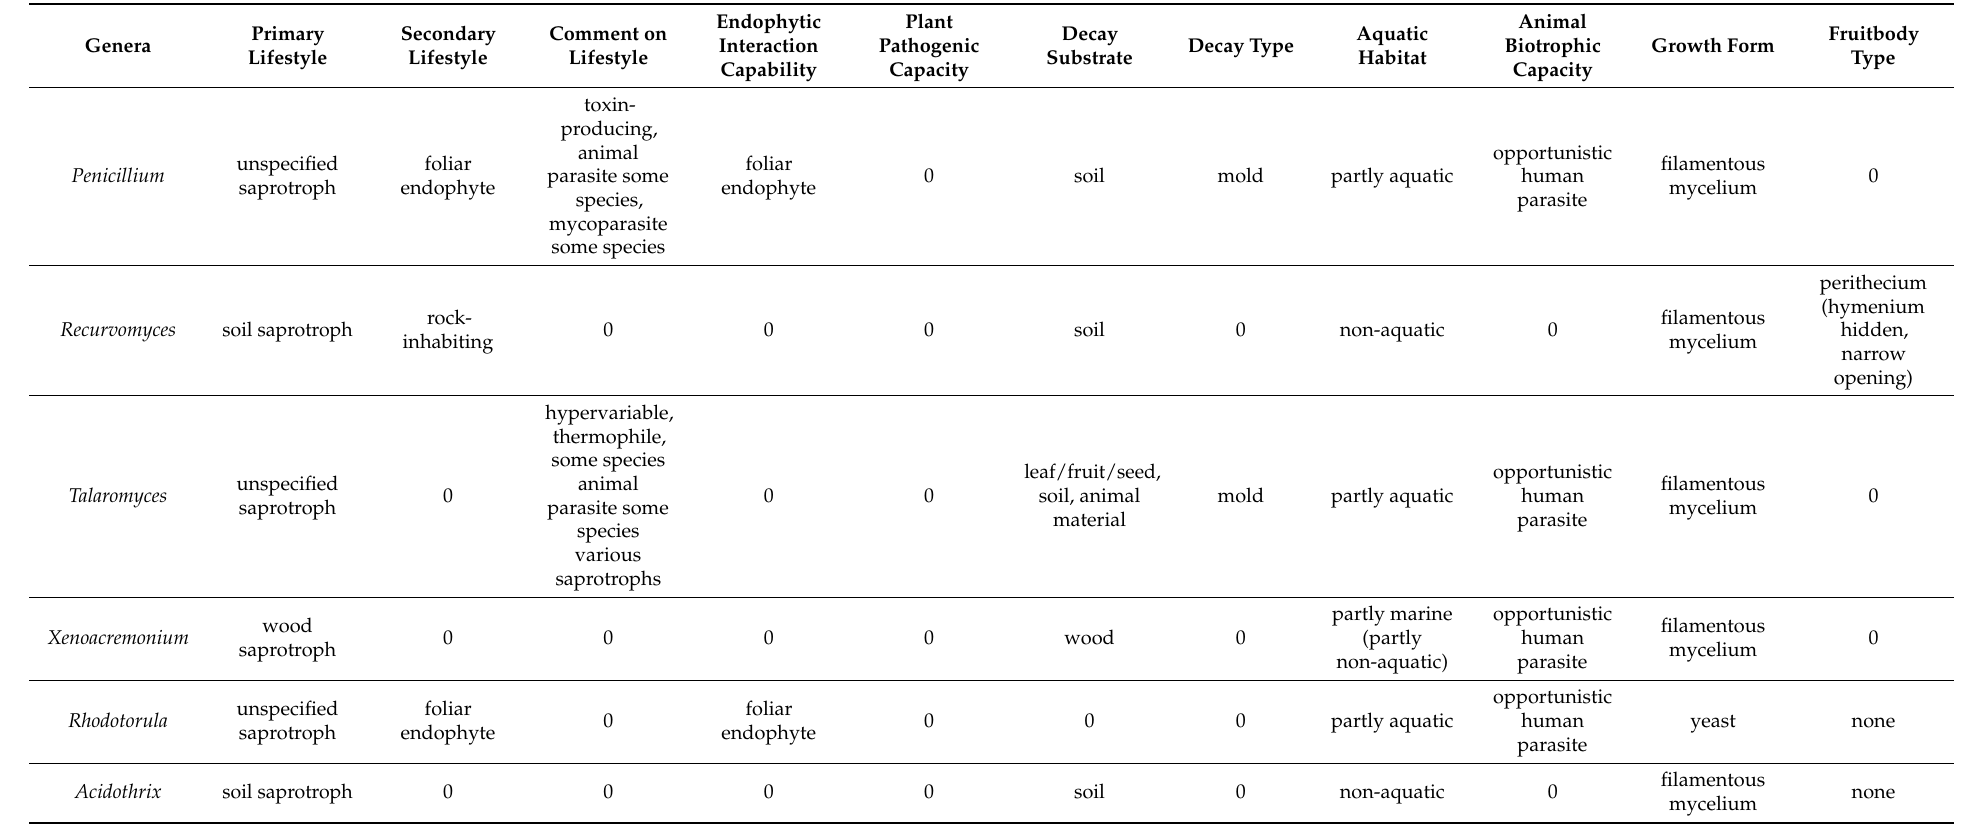
Table 4. Ecological information and functional assignment of dominant fungal taxa using FungalTraits